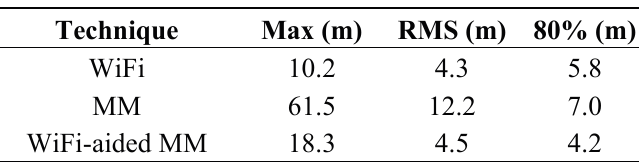
Table 1. Statistical values of navigation errors at the Energy Environment Experiential Learning